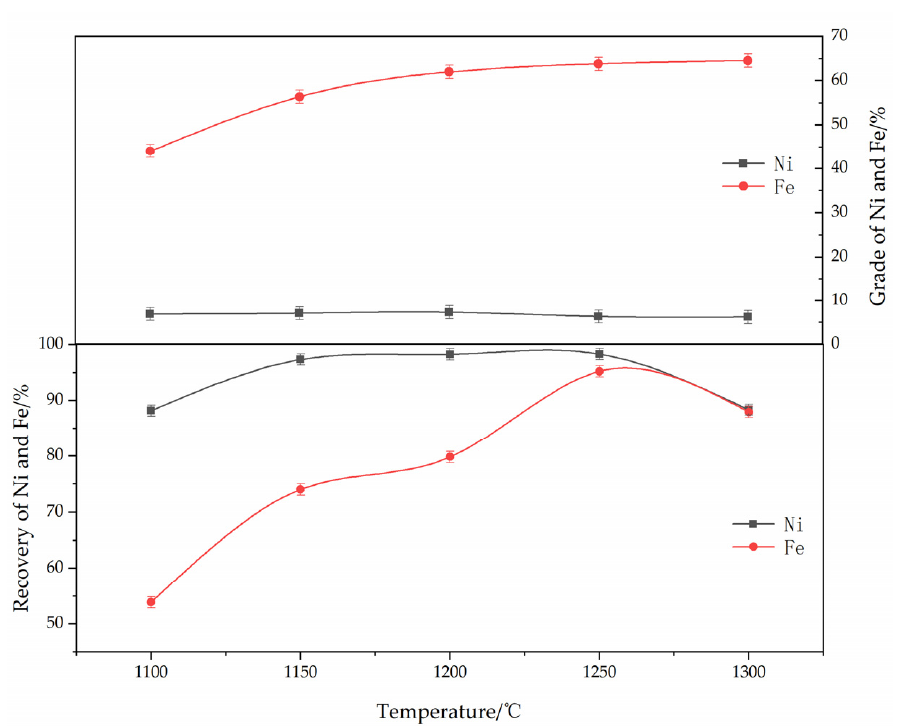
Figure 6. The effect of temperature on the grade and recovery of nickel and iron in ferronickel concentrate. (The ferronickel concentrate dosage was 30 wt.%, the roasting duration was 60 min, the reductant dosage was 8 wt.%, the magnetic separation was 150 mT).